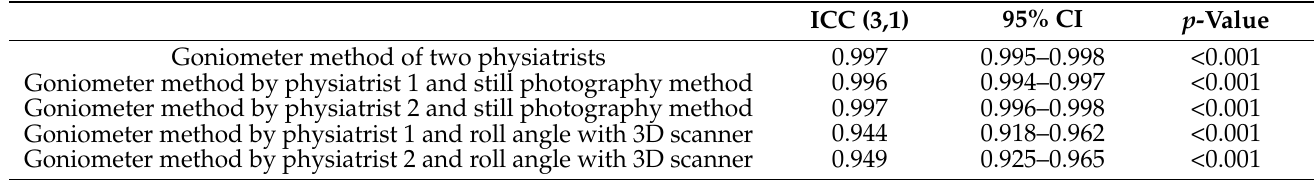
Table 2. Reliability of torticollis